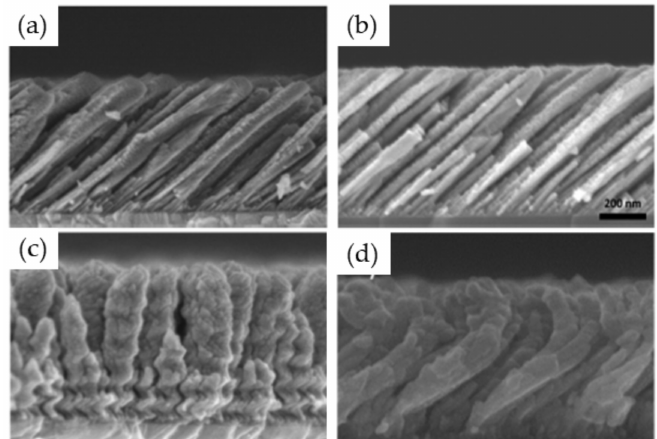
Figure 14. Cross-sectional SEM images of nano-columnar ( a ) TiO 2 and ( b ) Ti thin film deposited at 150 W, 0.13 Pa, and α = 85 ◦ . Cross-sectional SEM images of helicoidal ( c ) TiO 2 and ( d ) Ti thin film (cid:72) = 0.1 ◦ / s (adapted from [50] and [9] with permission from deposited at 150 W, 0.13 Pa, α = 85 ◦ , and s Elsevier, 2017 and 2015,